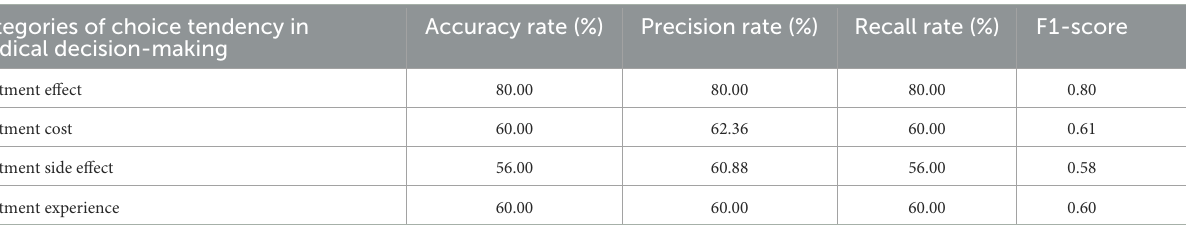
TABLE 3 Model evaluation effect of decision tree algorithm.